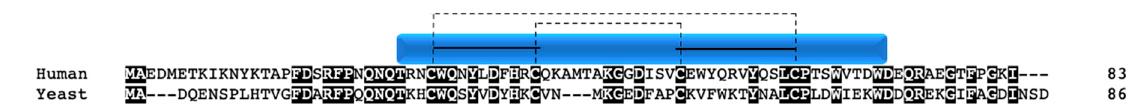
Figure 10. COX VIb1/Cox12p. Alignment of human and yeast COX VIb1/Cox12p protein sequences. Black boxes indicate conserved residues. Human sequence annotation is as follows: Blue box indicates the CHCH domain. Solid black lines indicate the CX 9 C-CX 10 C motif. Dashed lines indicate the cysteine pairs that form structural disulfide bonds.